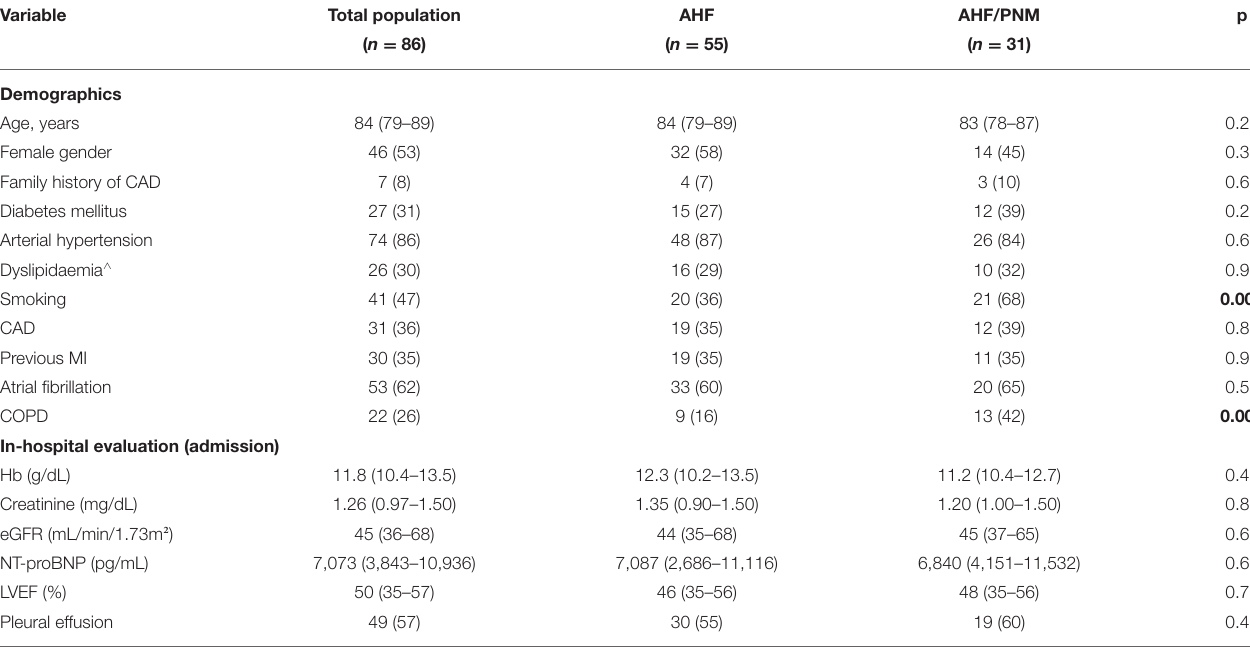
TABLE 1 | Patient clinical characteristics in the overall population, AHF and AHF/PNM groups.